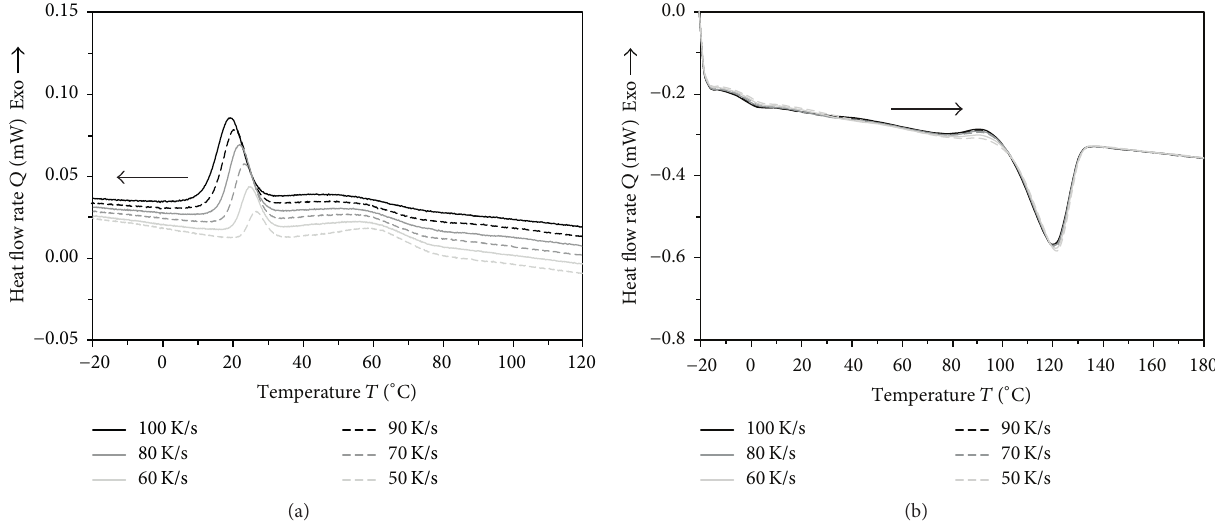
Figure 6: Heat flow rate measured during cooling (a) and second heating (b) of iPP with respect to the examined cooling velocities from 100 to 50